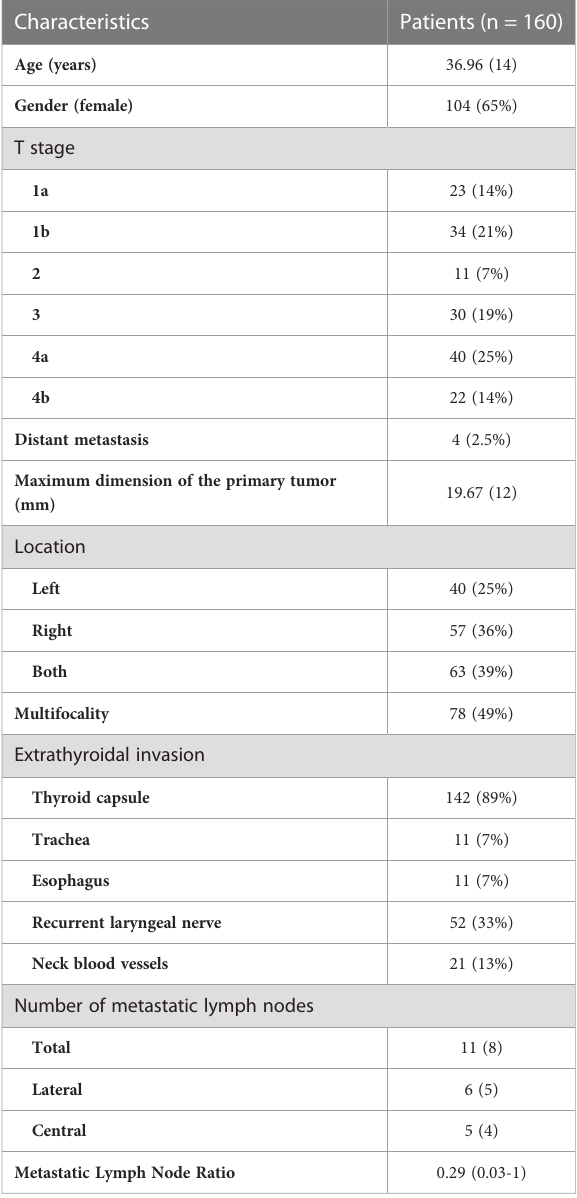
TABLE 1 Clinical